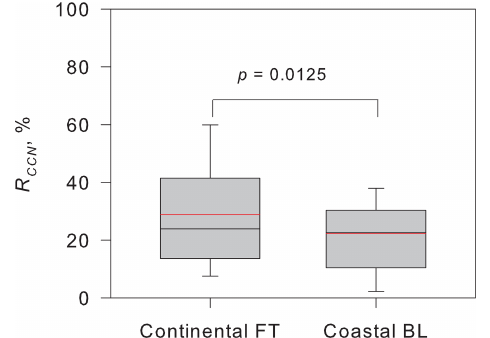
Figure 10. Comparison of R CCN in the continental free tropo- sphere (FT) and those in the coastal boundary layer (BL) during November–January in 2004–2006. p denotes the p value of the ANOVA variance test. Degrees of freedom for the ANOVA variance test were 155. Box plots show values of 90%, 75%, 50% (median), 25%, and 10%, denoted, respectively, by the top bar, top box line, black middle box line, bottom box line, and bottom bar. Red lines show mean